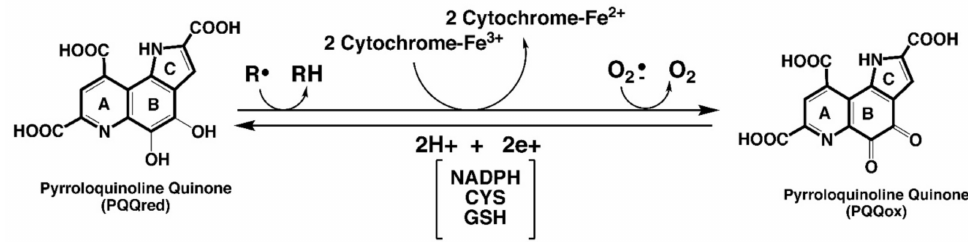
Figure 1. PQQ and electron transfer reactions. PQQ, in its reduced state, efficiently catalyzes electron transfer reactions. Potential substrates range from organic radicals to radical forms of oxygen. For many of the PQQ—dependent dehydrogenase systems, electron transfer may involve a heme-associated component. PQQ is reduced in reactions, utilizing either NAD[P]H, thiols such as cysteine and glutathione, enediols such as ascorbic acid, or aroxyl radical reductants such as the